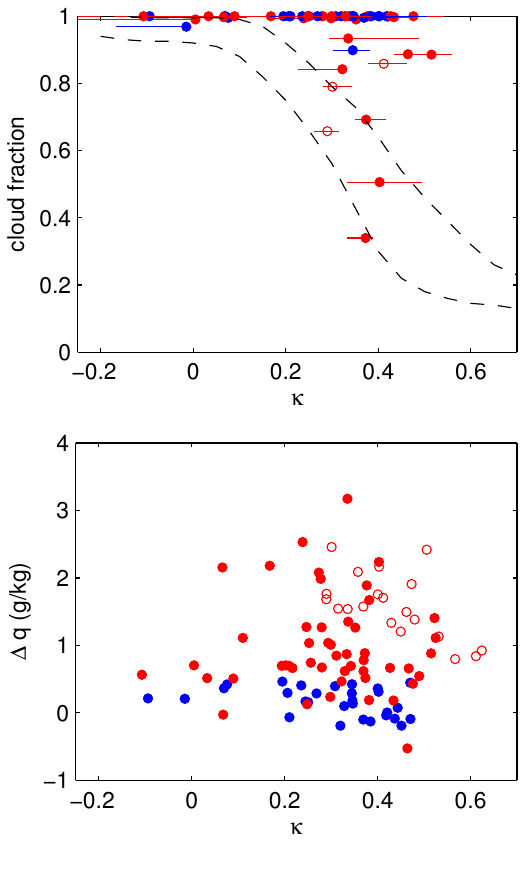
Fig. 12. Cloud fraction (top) and profile moisture decoupling index (bottom) as a function of the inversion jump parameter κ . Well- mixed profiles are marked in blue, and decoupled profiles in red. Data from POC flights are shown as hollow markers. Only profiles with adjacent subcloud legs before 10:00LT are included in the left panel to reduce the influence of diurnal forcing on the cloud frac- tion. Uncertainty estimates for κ are indicated by bars in the left panel, and the dashed curves correspond to the range of LES results presented in Lock